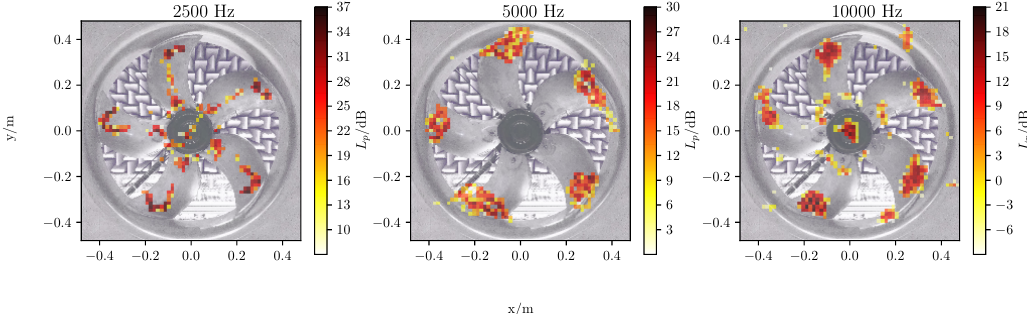
Figure 11. One-third octave band source maps for 2.5, 5 and 10 kHz obtained with the spiral array and barycentric interpolation between the microphones using